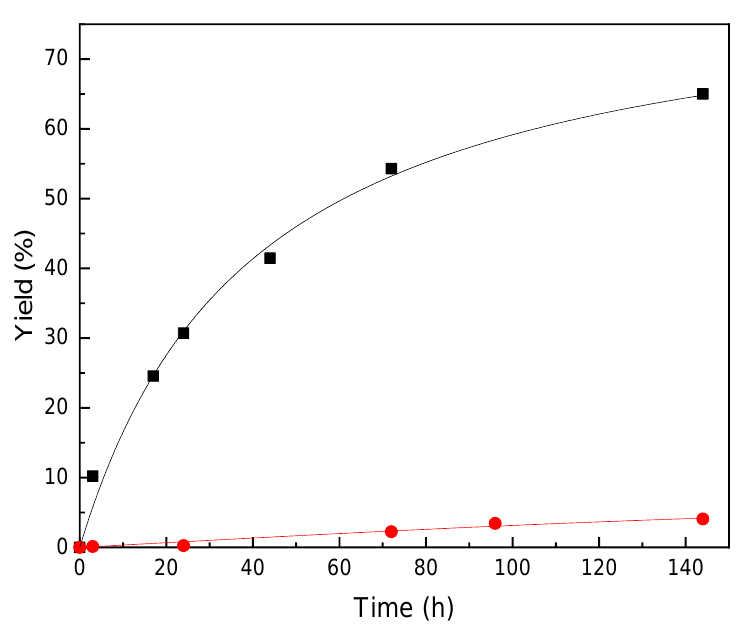
Figure 2. Synthesis of ascorbyl palmitate with Novozym 435 (black squares) and PS-octyl-silica (red circles). Reaction conditions: 87 mM of AA, 1:5 AA:PA molar ratio, 5 mL of 2M2B, 12 g / L of enzyme and 14 g / L of molecular sieve 3A, at 45 ◦ C and 150 rpm. Table 2. Summary of parameters of synthesis of ascorbyl palmitate (AsPa) with the immobilized